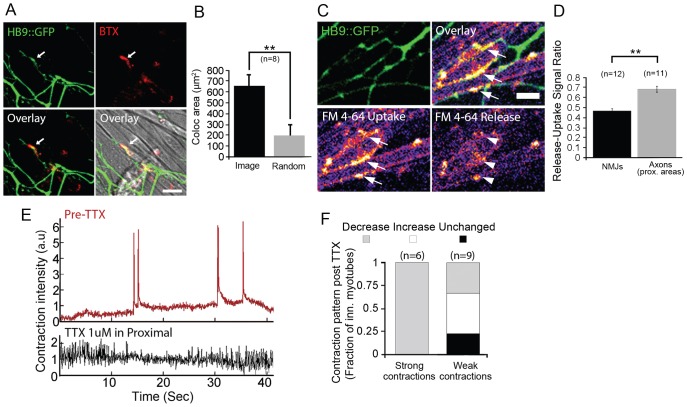
Formation of functional neuromuscular junctions in the muscle compartment. (A) Confocal images of specific colocalization (arrows) of AChR clusters in myotubes (BTX, red) and HB9::GFP (green) axons. Scale bar: 20 µm. (B) Mean colocalized area compared to random colocalization after image flipping (random). Eight images taken from a representative co-culture were analyzed. Data show the mean±s.e.m.; **P<0.01 (one-tailed Student's t-test). (C,D) Pre-synaptic uptake and release of FM-4-64 dye in NMJs. Representative confocal images using a 20× objective (left) showing HB9::GFP axon terminals (green) in contact with myotubes with puncta of uptaken FM dye (arrows) and 5 min after KCl-glutamate-induced release (arrowheads). Scale bar: 10 µm. The graph shows the mean fold reduction in the FM dye signal in NMJs compared to that in proximal (prox.) areas in a representative co-culture (±s.e.m.); **P<0.01 (one-tailed Student's t-test). (E) Representative time trace of contraction in an innervated myotube pre- and post-addition of 1 µM TTX to the neuronal compartment (see also supplementary material Movie 3). a.u., arbitrary units. (F) The fraction of myotubes displaying altered or unaffected levels of innervation-induced contractions compared to weak spontaneous contractions in innervated (inn.) myotubes post- and pre-TTX addition to the neuronal compartment.